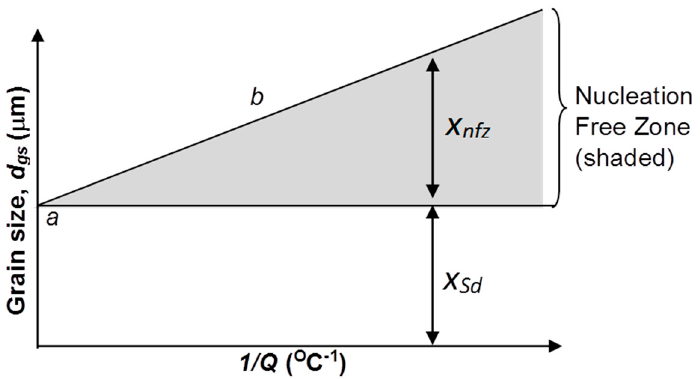
Figure 1. Illustration of the constants a and b where the horizontal line assumes a constant number density of nucleant particles. Adapted from [16].